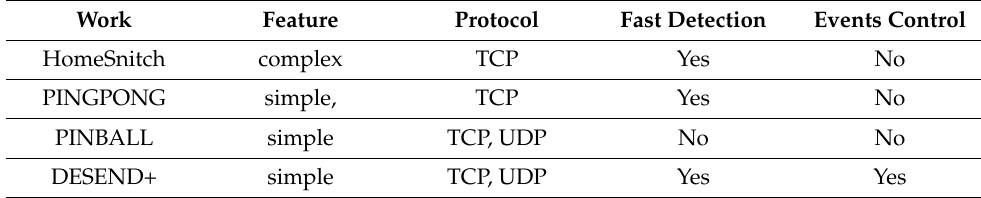
Table 2. Alternative